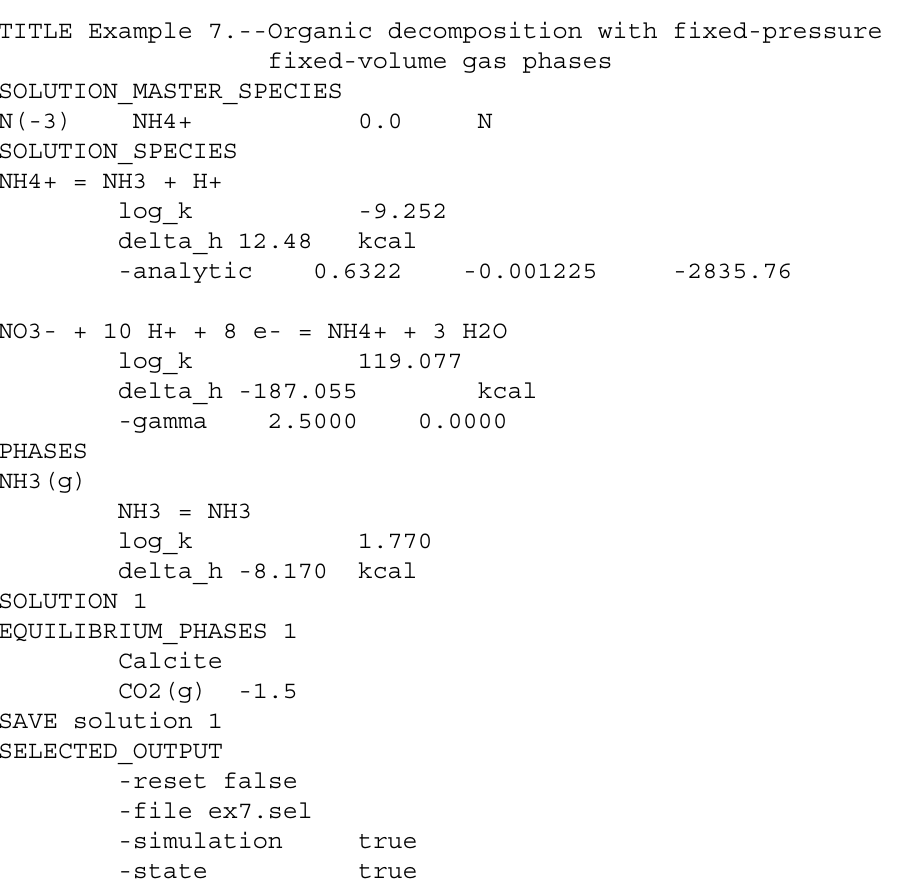
Table 26. Input file for example 7. TITLE Example 7.--Organic decomposition with fixed-pressure